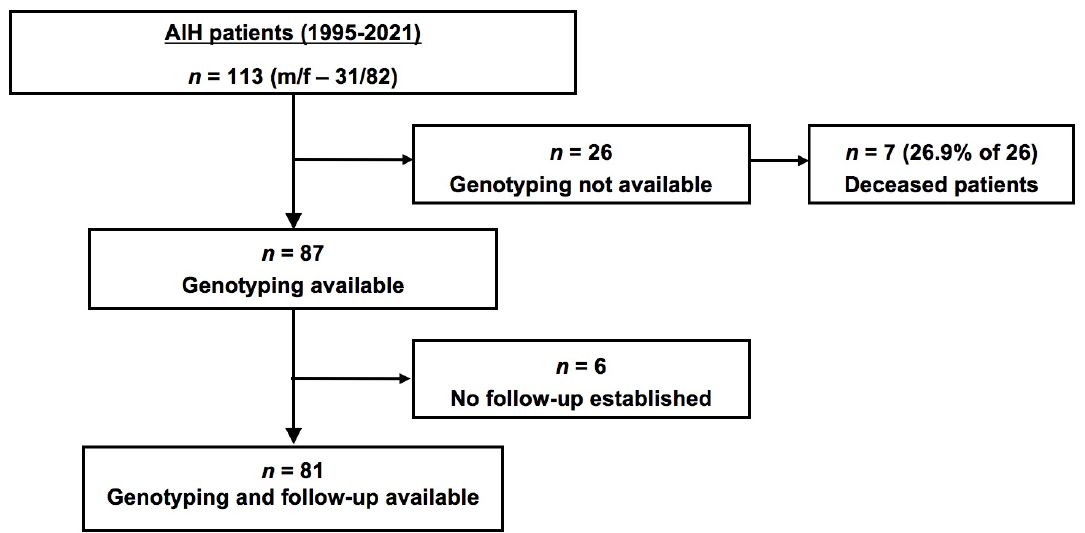
Figure 1. Flow chart of the study cohort. A total of 113 patients were diagnosed with AIH, 87 of those were available for genotyping, and 81 had genotyping and follow-up data available. Abbreviations: AIH, autoimmune hepatitis; m, male; and f, female. Table 1. Patient characteristics of the whole cohort at baseline.